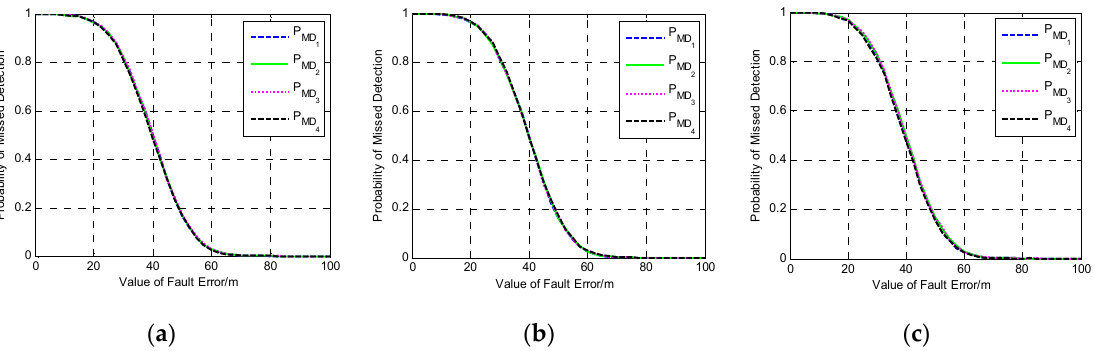
Figure 4. The fault detection results at three di ff erent epochs. ( a ) The detection results at the first epoch; ( b ) The detection results at the second epoch; ( c ) The detection results at the third epoch.